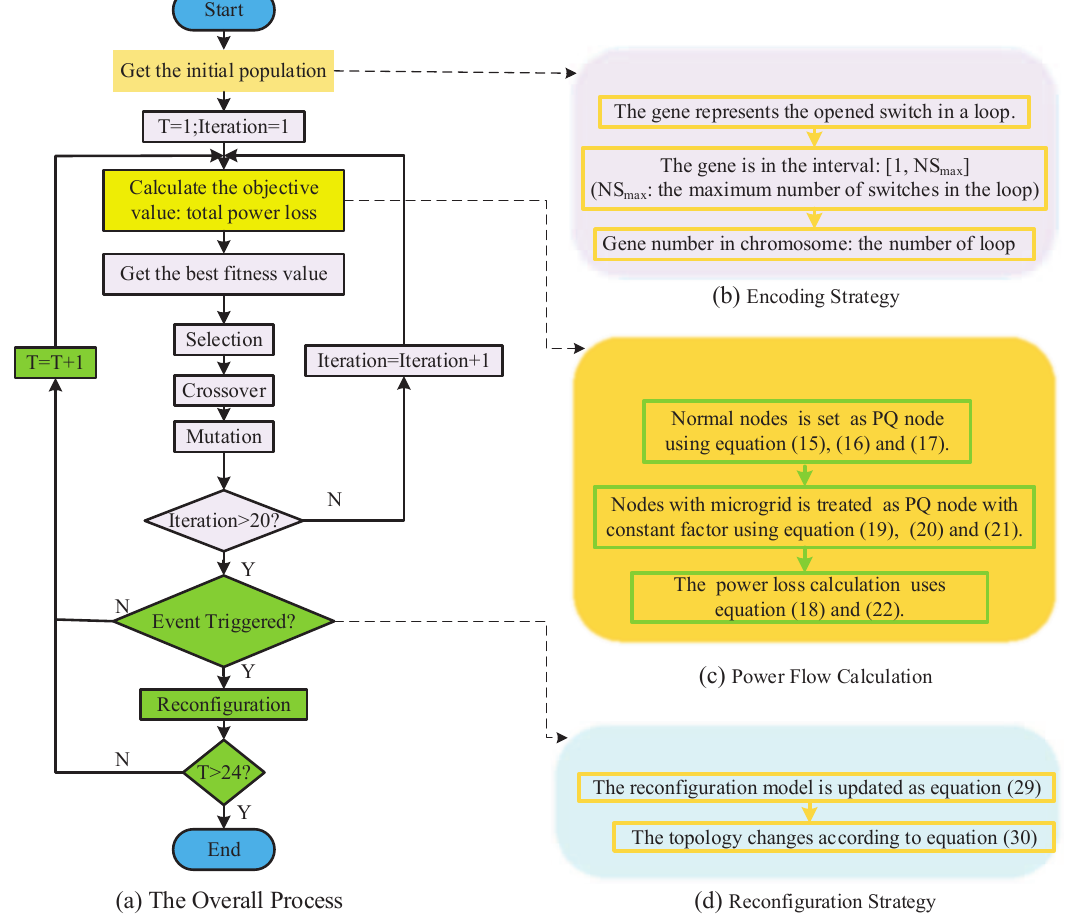
Figure 3. Flowchart of Reconfiguration